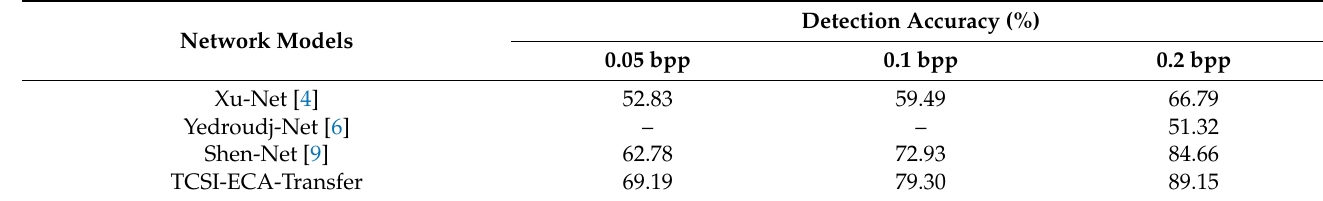
Table 6. Accuracy comparison with other models when using the HUGO